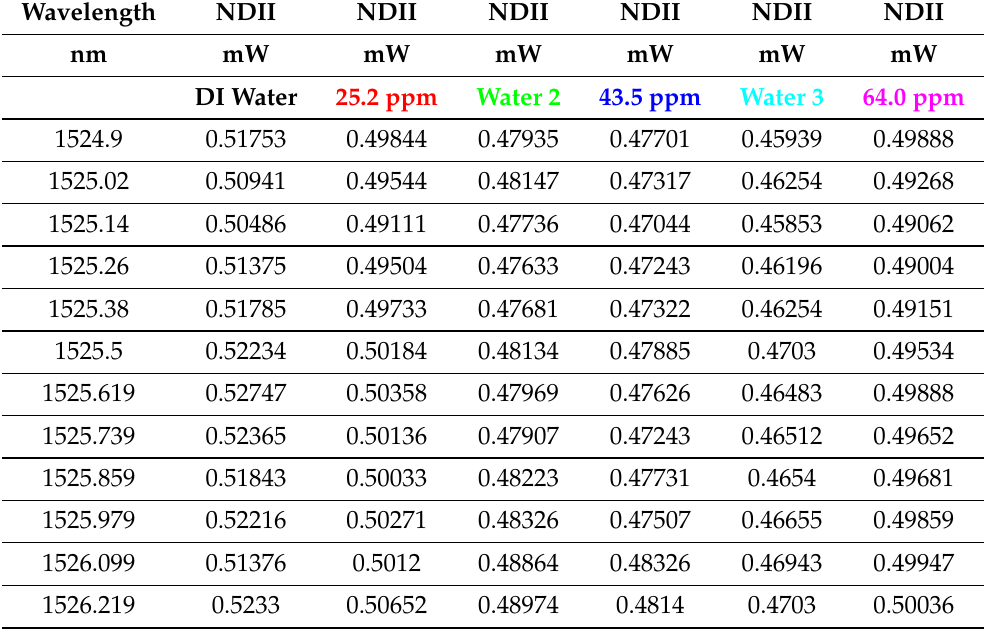
Table A2. Normalized denoised interference intensity